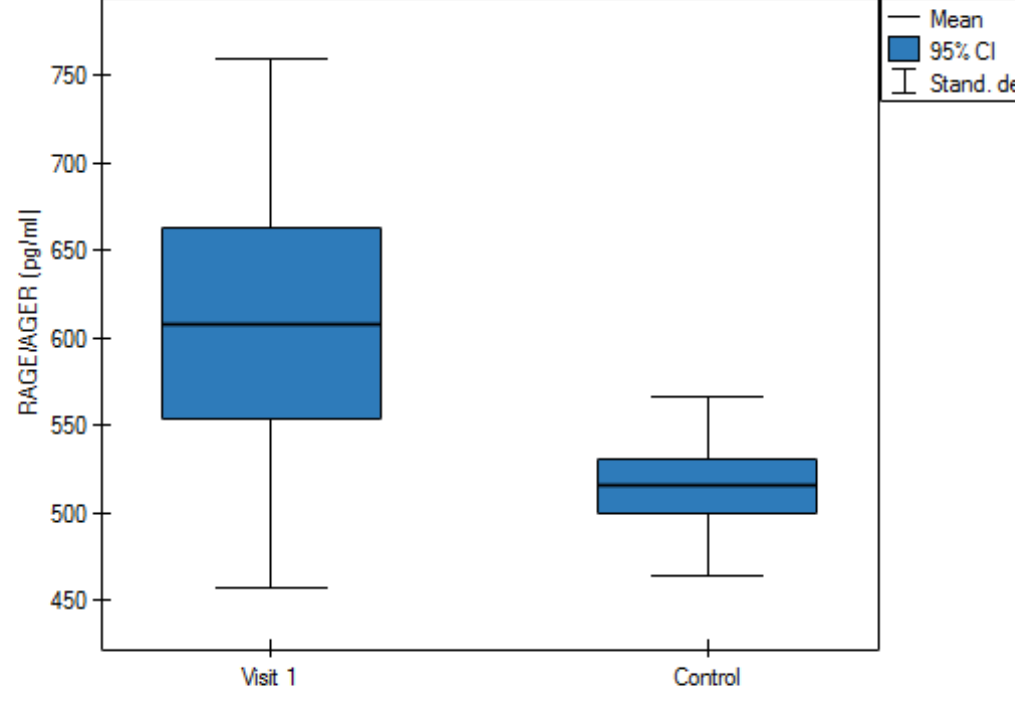
Figure 2. Average value of plasma concentration of receptor for advanced glycation end products (RAGE/AGER) in the control group and study group during the first and second visit.